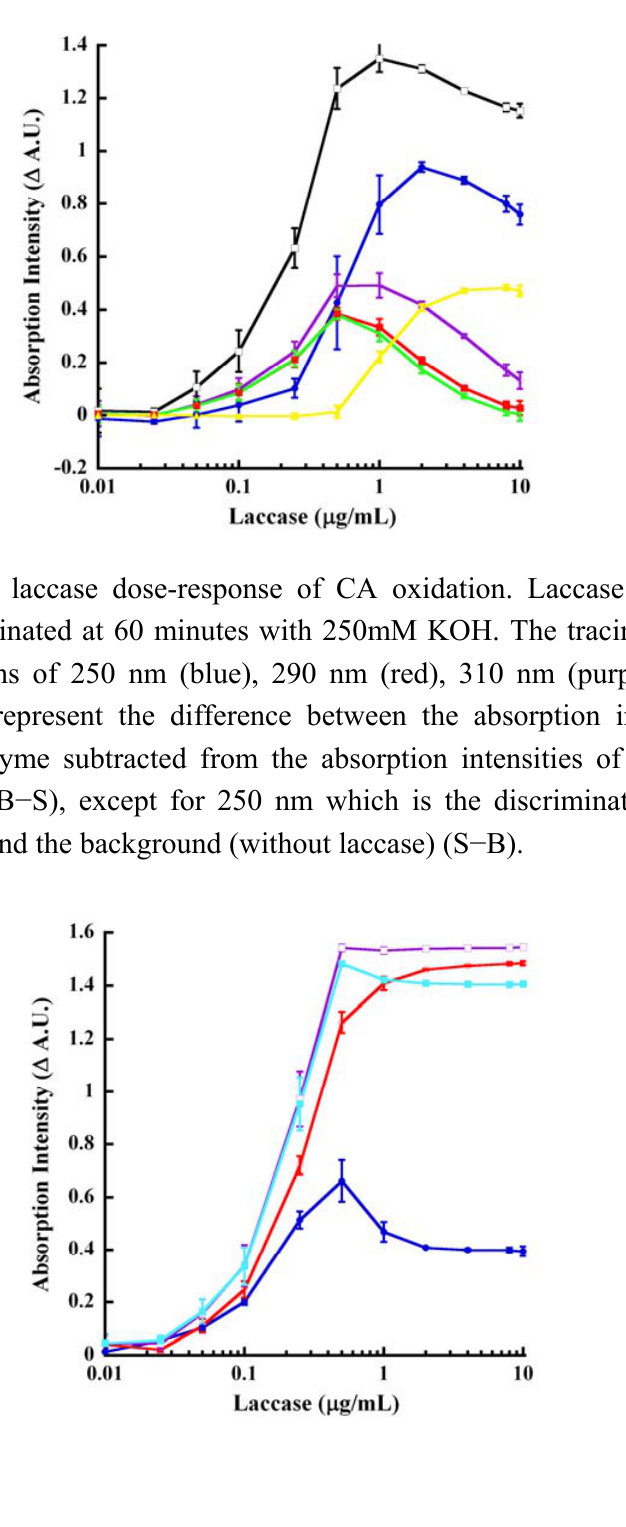
Figure 6A. Laccase dose-response at 57 minutes of CA oxidation. Increasing and indicated concentrations of laccase were reacted with 500 μ M CA in pH 4.5 buffer for 57 minutes as described in the legend to Figure 3B. The various colored tracings represent the following absorption wavelengths: 220 nm (blue), 240 nm (purple), 260 nm (black), 295 nm (red), 300 nm (green) and 320 nm (yellow). All tracings represent the difference between the absorption intensities of the reactions without enzyme subtracted from the absorption of the reactions in the presence of laccase (B − S), except for 320 nm which is the discrimination between the signal (with laccase) and the background (without laccase enzyme) (S − B).